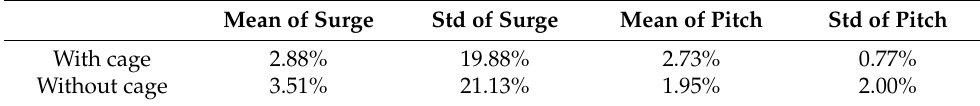
Table 7. Percentage comparison results of motion response under 1st and 1st +QTF wave loads. Mean of